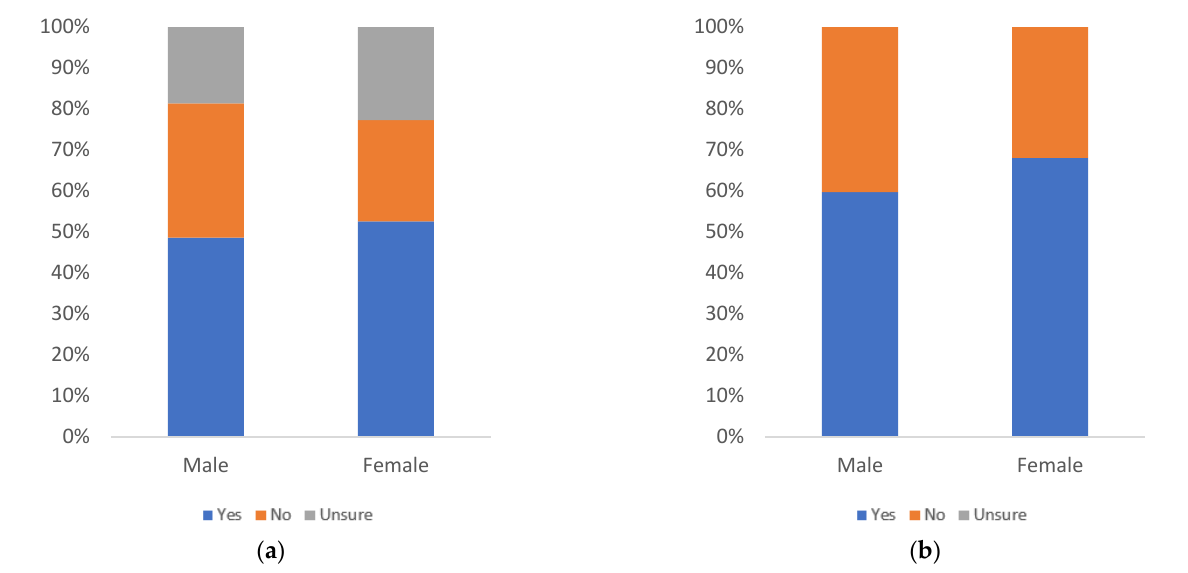
Figure 35. Label trustworthiness judging use, by gender: ( a ) with uncertain respondents (left) and ( b ) without uncertain respondents (right).